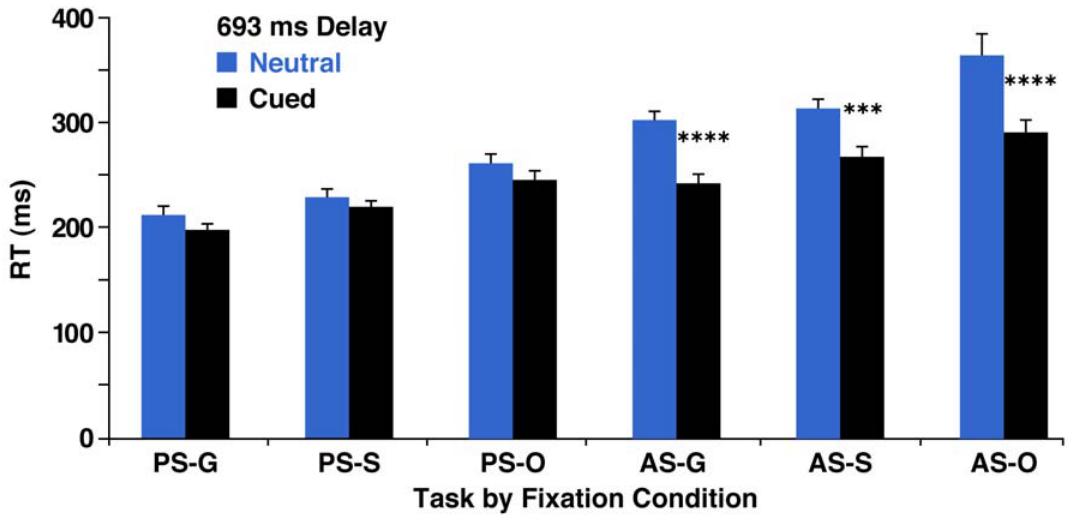
FIGURE 7. Response times, Experiment 4. Mean response times for Experiment 4 (693-ms delay only). Cueing effects (cued vs. neutral trials) are compared for prosaccade and antisaccade task performed with all three fixation conditions. Fixation condition had no significant effects on cueing effects. PS, prosaccade task; AS, antisaccade task; G, gap condition; S, step condition; O, overlap